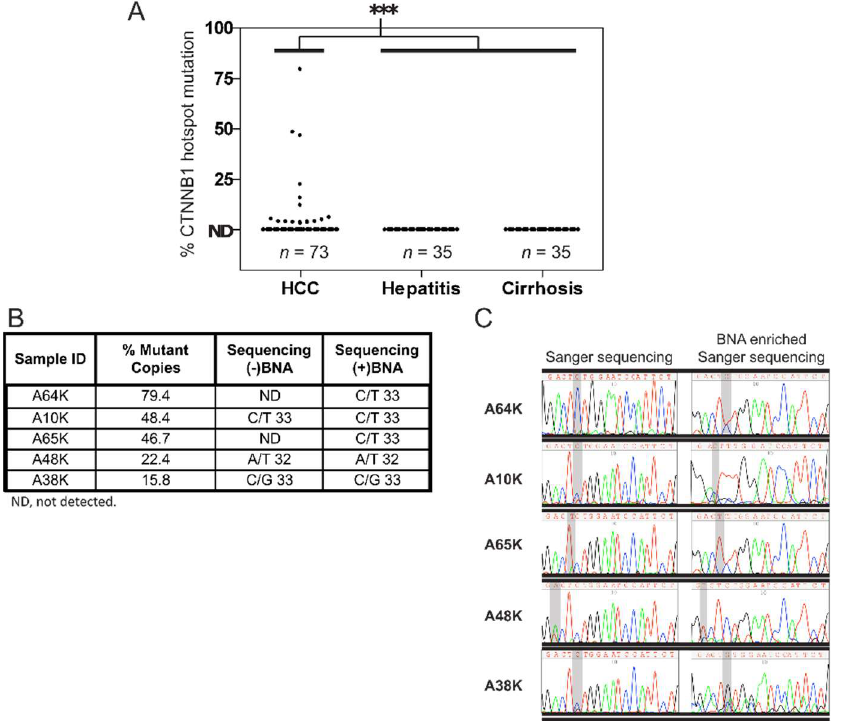
Figure 2. Analysis of CTNNB1 mutations in tissue samples from patients with different liver dis- eases. ( A ) CTNNB1 hotspot mutant allele frequencies obtained by the CTNNB1 32-37 mutation qPCR assay in liver tissues of patients with HCC, hepatitis, or cirrhosis. In the HCC subset ( n = 73), 18 patients tested positive, while all of the hepatitis ( n = 35) and cirrhosis ( n = 35) samples tested negative. ***, p <0.001. ( B ) Validation of the CTNNB1 32-37 mutation qPCR assay by Sanger sequencing. Five samples identified as positive by the qPCR assay with mutation frequencies of >15% were eval- uated by Sanger sequencing. Of these five samples, three had detectable CTNNB1 mutations. When Sanger sequencing was repeated after enrichment for the mutation using the BNA NC [NMe] in the PCR amplification reaction, CTNNB1 mutations in the other two samples were also confirmed. The right panel shows Sanger sequencing chromatograms with and without BNA NC [NMe] enrichment.